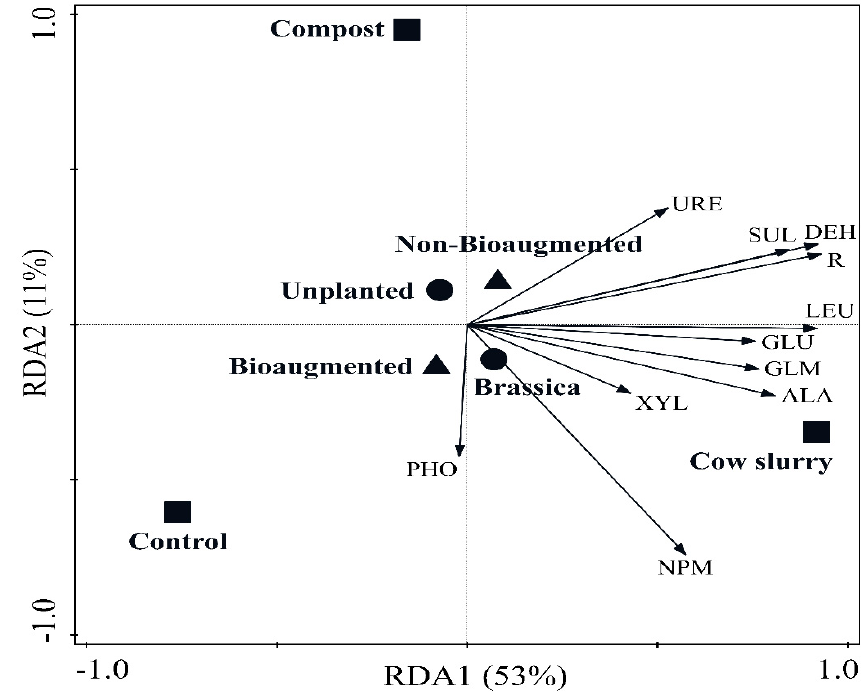
Figure2. Biplotoftheredundancyanalysis(RDA)performedonsoilmicrobialactivityparameters. Figure 2. Biplot of the redundancy analysis (RDA) performed on soil microbial activity parameters.